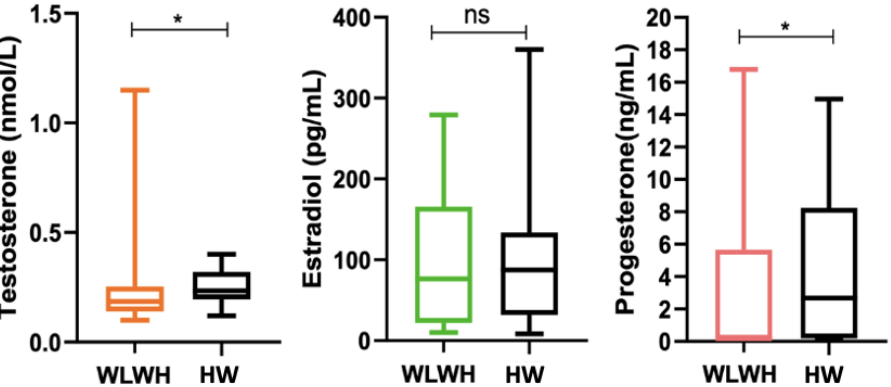
Figure 4. Estimation of sexual hormones in WLWH and HW. The differences between the two groups were evaluated using the nonparametric Mann–Whitney test. Data are shown as median (box plots). Statistical significance ( p ) is reported in the graphics. * p < 0.05.